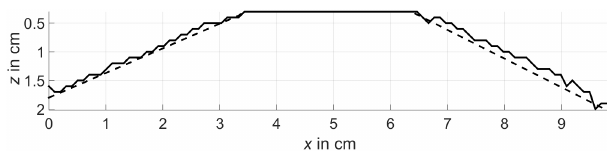
Figure 6. Comparison of the detected material boundary (solid line) and its analytical contour (dashed line).